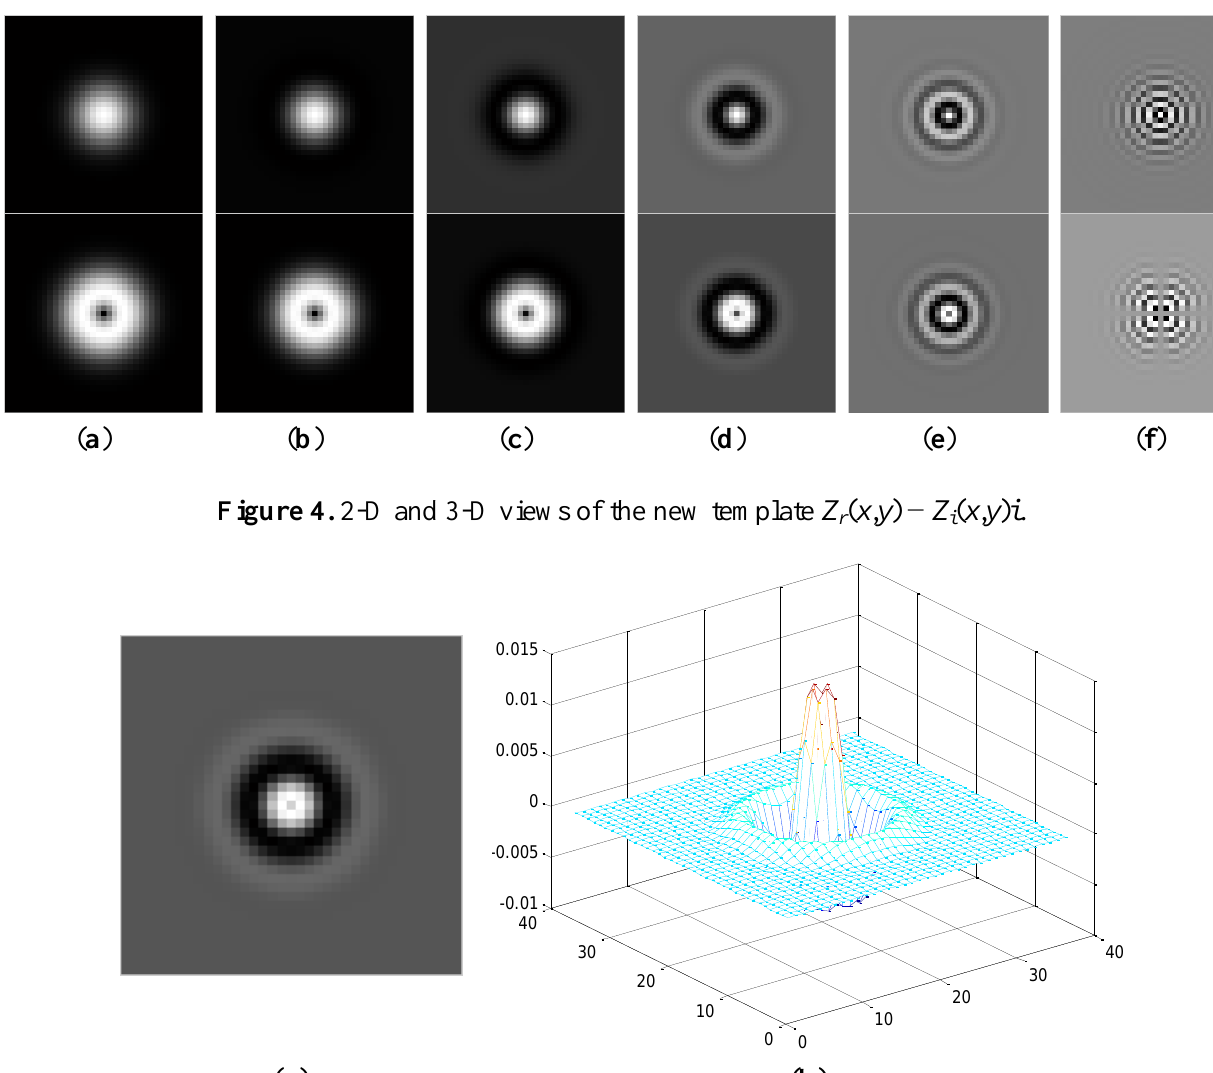
Figure 3. A bank of CGF with σ = 4, F = {4,8,16,32,64,128}/256. The first row is the real parts and the second row is the imaginary part.